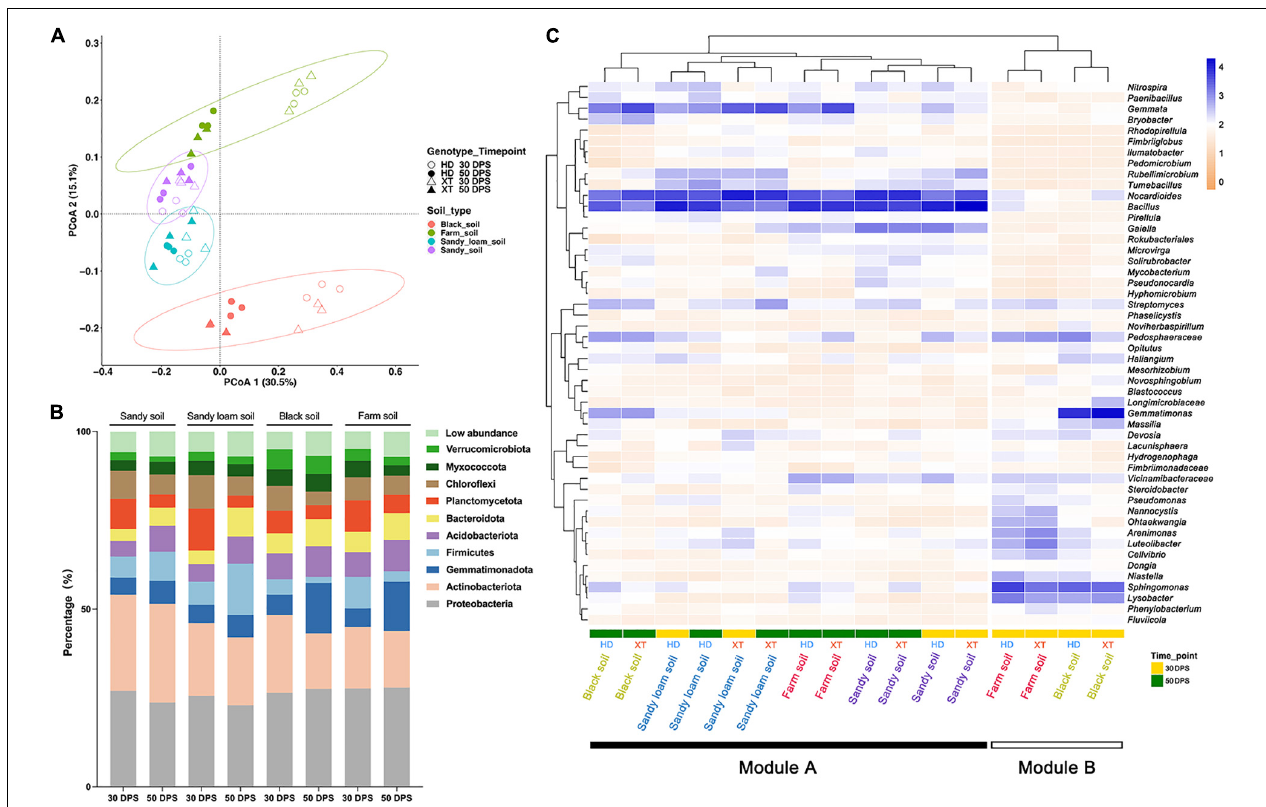
FIGURE 3 | Differences in the composition of bacterial communities in different soils, cultivation times and genotypes. (A) PCoA (for principal coordinates PCo1 and PCo2) with Bray–Curtis distance shows that the different soils are separated in the area on the abscissa. Different samples assemble four circles regularly. The hollow circle represents HD at 30 DPS; the Solid circle represents HD at 50 DPS; the hollow triangle represents XT at 30 DPS; the solid triangle represents XT at 50 DPS. Purple is sandy soil; blue is sandy loam soil; green is farm soil; red is black soil. (B) The percentage of the bacterial community on the phylum level in different soils at different cultivation times. Different colors represent different bacterial phyla. (C) A heat map and hierarchical clustering show the average relative abundance of the top 50 genera of all samples. Yellow represents 30 DPS, and the green represents 50